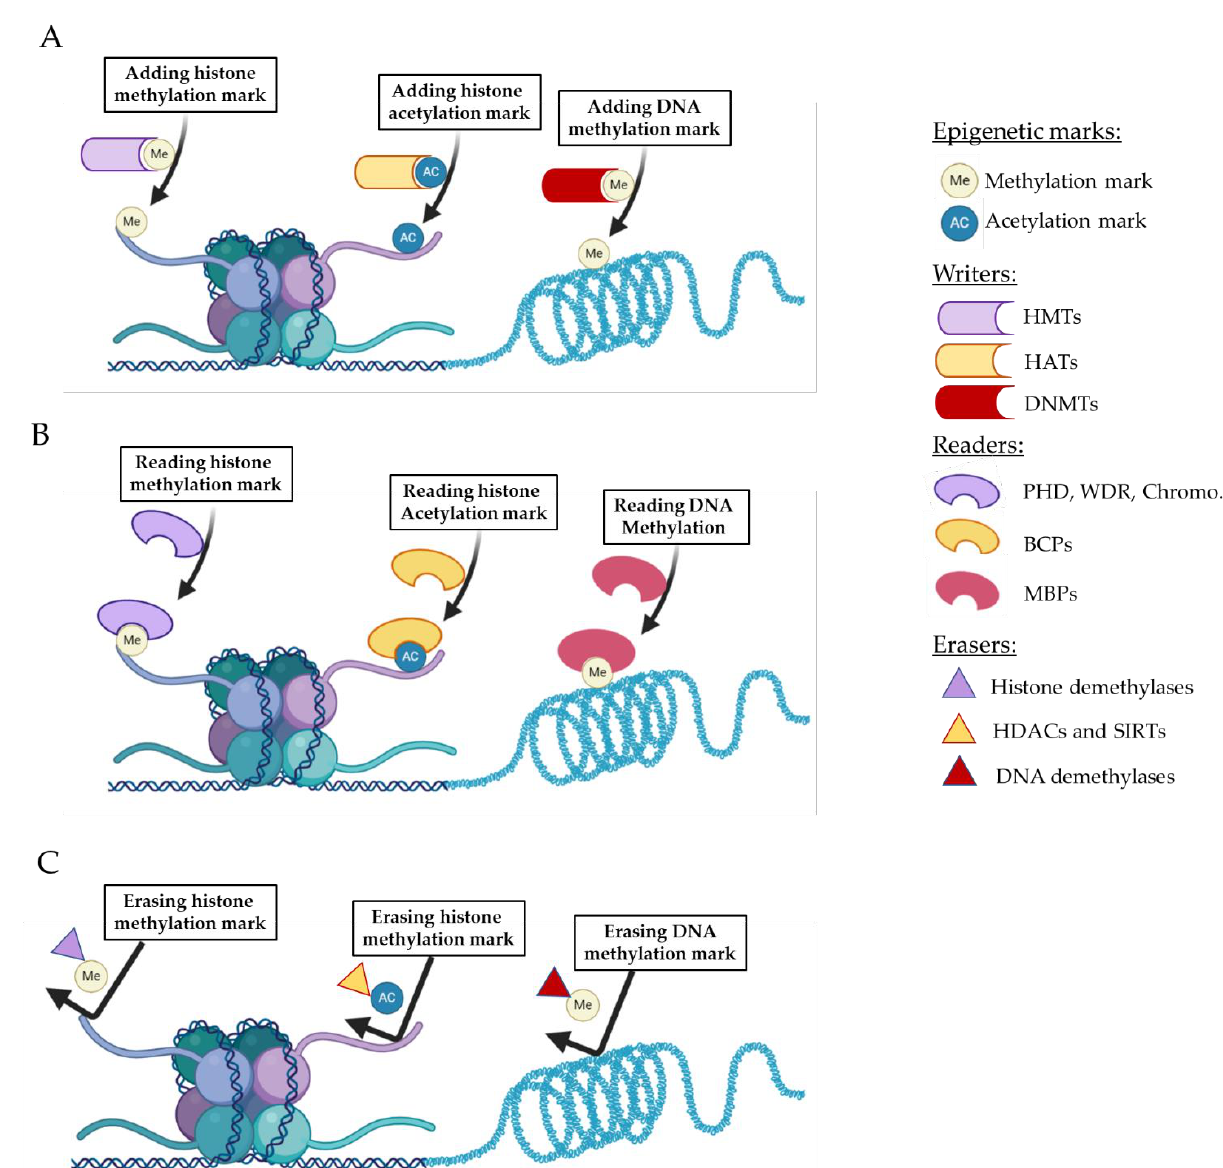
Figure 1. DNA methylation and histone modifications. Post-translational modifications of histones and DNA methylation provide a fine-tuned mechanism for regulating chromatin structure and dynamics. Panel ( A ) depicts methylation and acetylation of histone tails that involve the addition of methyl group (Me) and acetyl group (AC), respectively. These processes are catalyzed by the epigenetic writers histone methyltransferases (HMTs) and histone acetylases (HATs), respectively. DNA methylation is catalyzed by the epigenetic writers DNA methyltransferases (DNMTs), including DNMT1, DNMT3a, and DNMT3b, which add a methyl group on to the 5-carbon of the cytosine ring. Panel ( B ) illustrates examples of epigenetic readers that possess specialized domains that recognize specific covalent histone or DNA modifications and respond to upstream signals. Such crosstalk generates a different binding platform for the recruitment of other regulatory proteins, ultimately controlling the chromatin accessibility to transcription factors and gene transcription, such as plant homeodomain (PHD), WD40-repeat (WDR) proteins, and chromo domains that recognize histone methylation marks, broomodomian-containing protiens (BCPs) that recognize histone acetylation marks, and the methyl-CpG-binding proteins (MBPs) that recognize methylation of DNA. Panel ( C ) shows examples of epigenetic eraser proteins that can remove modifications from DNA or histones to regulate gene expression.